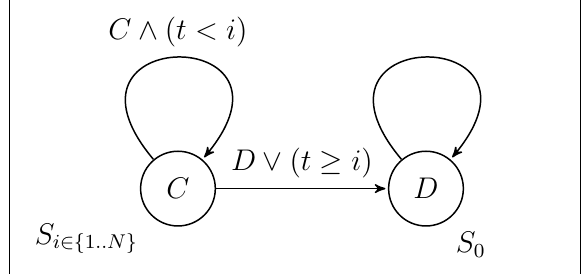
Figure 1. Finite state machine illustrating the first strategy set, Γ action to perform is in the node, and transitions are taken on the basis of the opponent’s action in the previous round (or based on the previous round number t ). All strategies start in the left node (C), except S that starts with defection in the right node (D). S 0 conditionally for i rounds after which it starts to